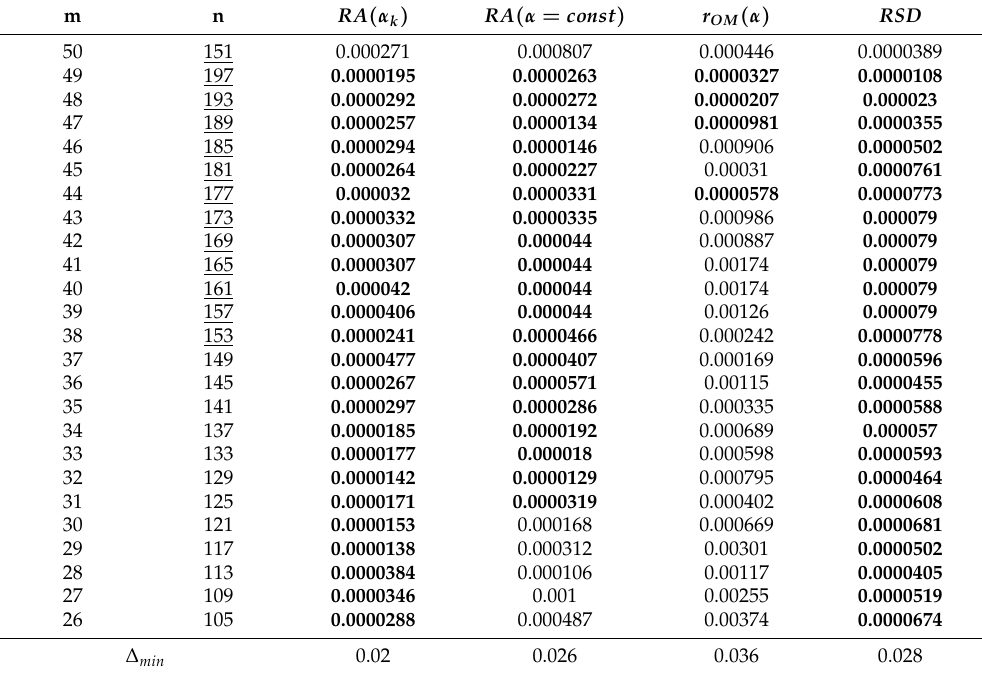
Table 10. Results of function f 6 ( x ) approximation by a sigmoidal ANN with a regularizer R γ ( w ) , m 0 = 50, N 0 = 150, α = 10 − 7 , S ( DT 10.000, f ) . The values with the limiting order of accuracy are given